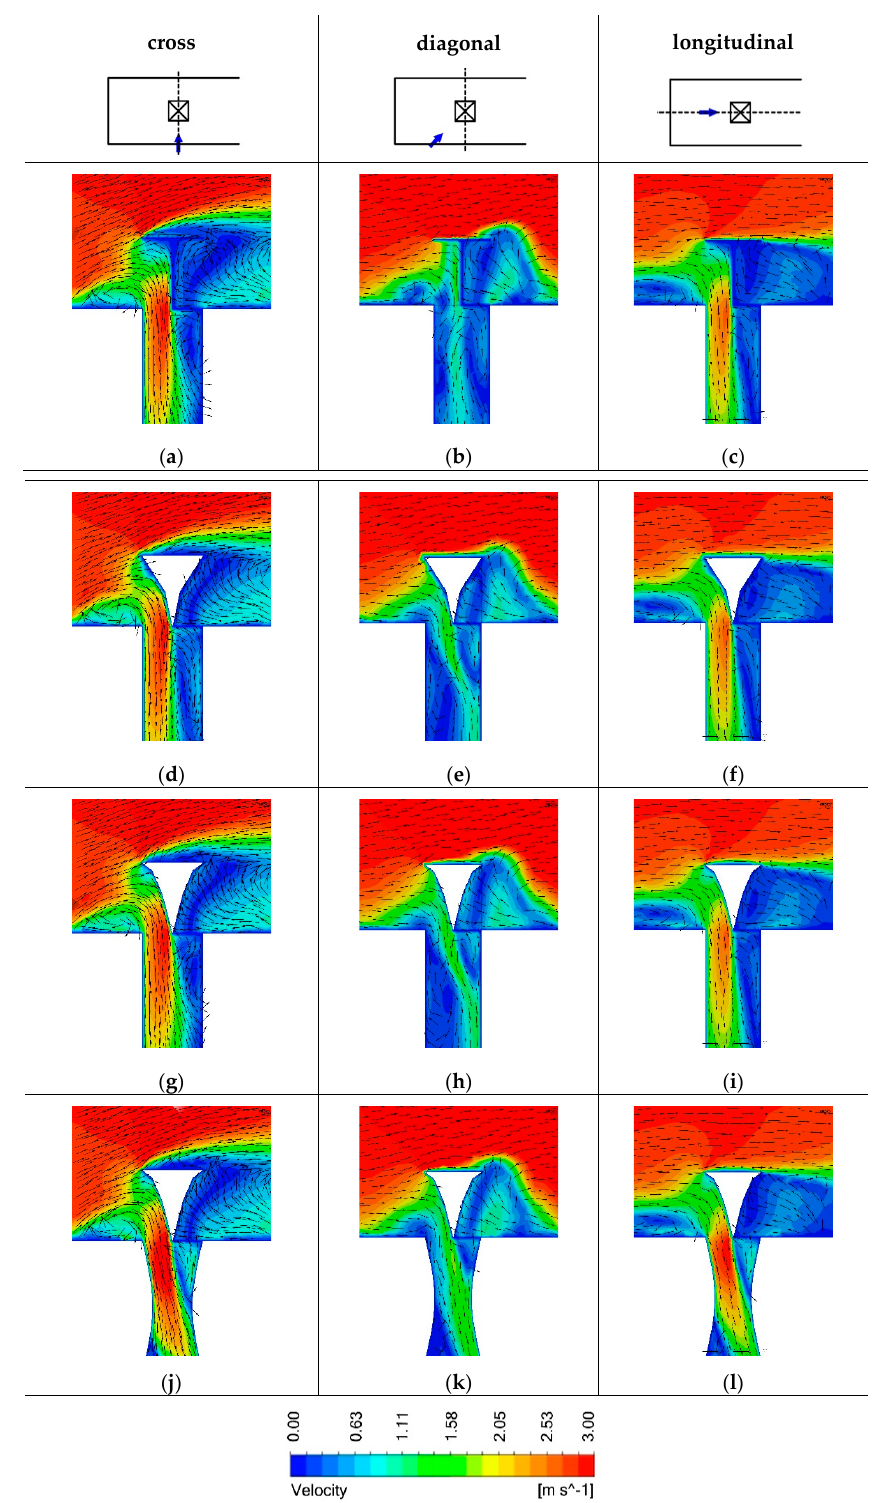
Figure 10. Representation of flow fields around the wind catcher versions by velocity color maps and normalized tangentially projected vector fields on a vertical section: ( a – c ) ‘empty’; ( d – f ) ‘circle’, ( g – i ) ‘parabola’, ( j – l ) ‘hyperbola’—in the following order: cross ( a ), diagonal ( b ) and longitudinal ( c ) wind direction.